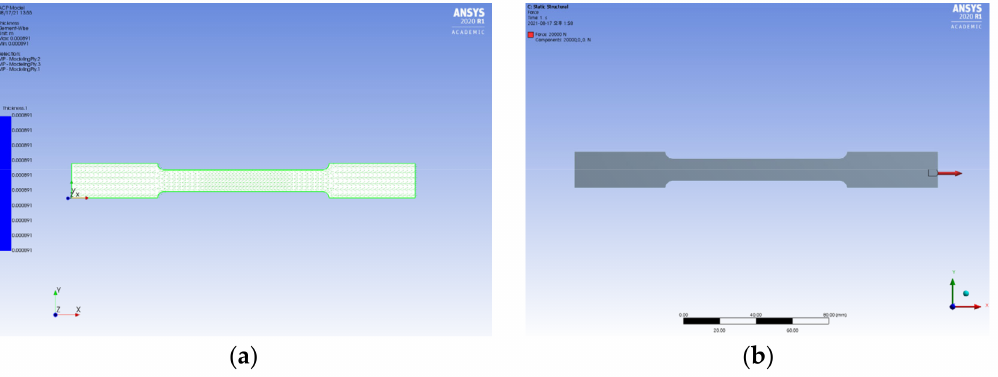
Figure 17. A specimen for the tensile coupon simulation. ( a ) Assigned ply information in ANSYS ACP, ( b ) Applied load in